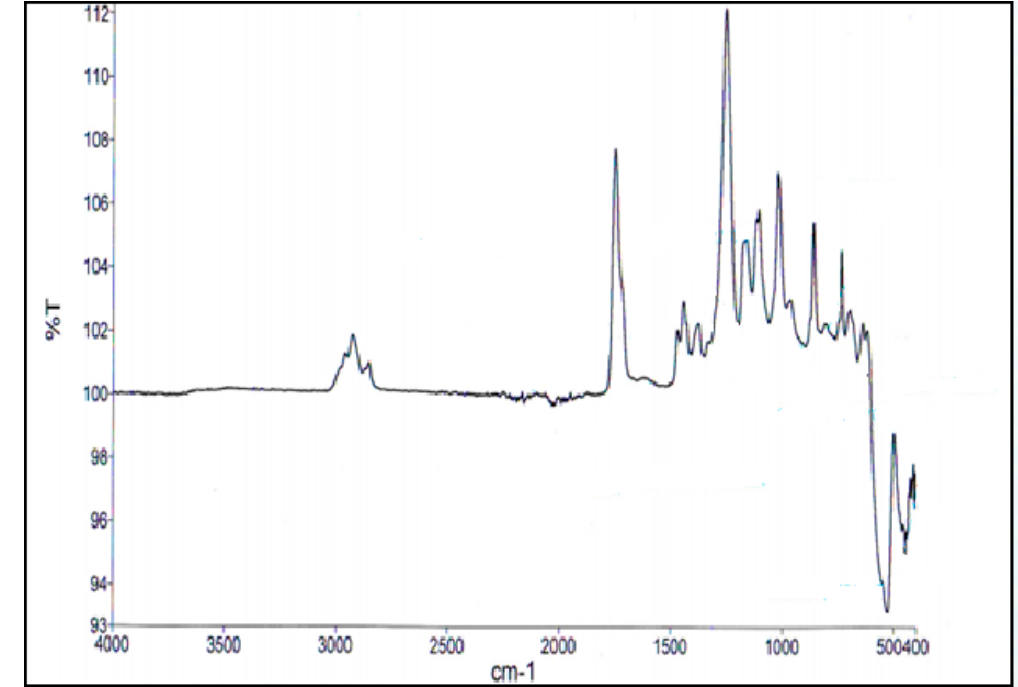
Figure 10. FTIR of cobalt ferrite CoFe 2 O 4.